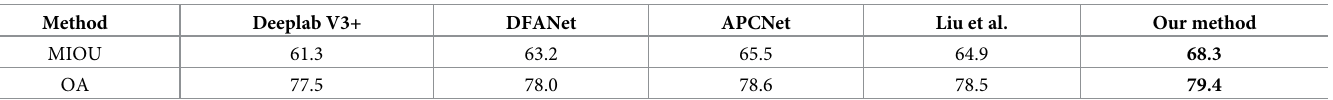
Table 4. Comparison of MIOU and OA values between our method and the other four state-of-the-art methods on the underwater dataset. The best results are in bold. Method